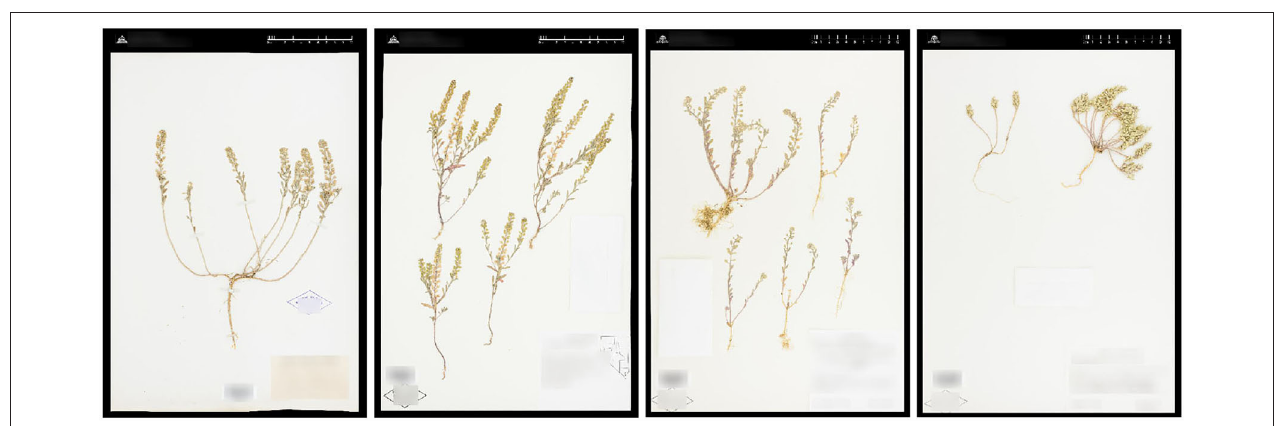
Frontiers in Plant Science | www.frontiersin.org